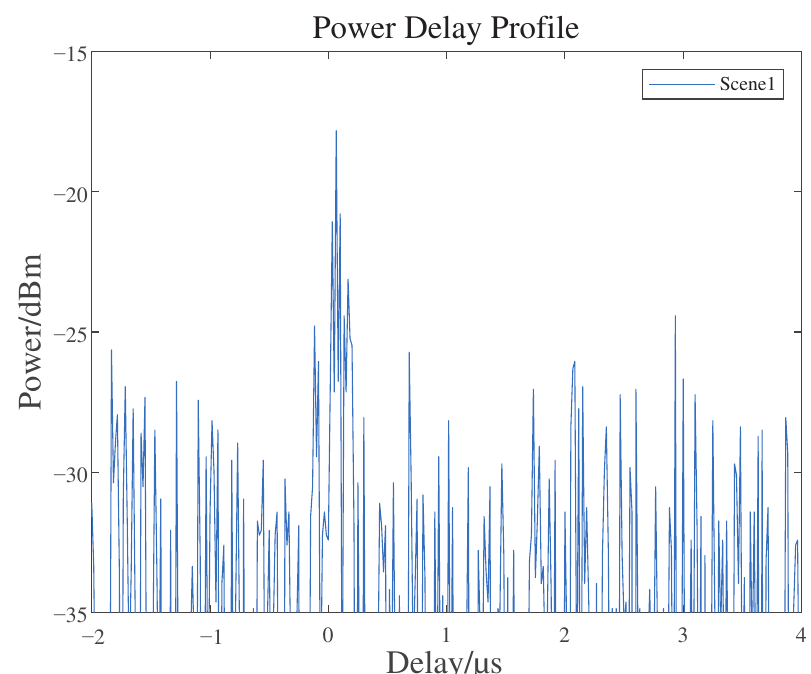
Figure 9. Channel sounding PDP of scene 1.